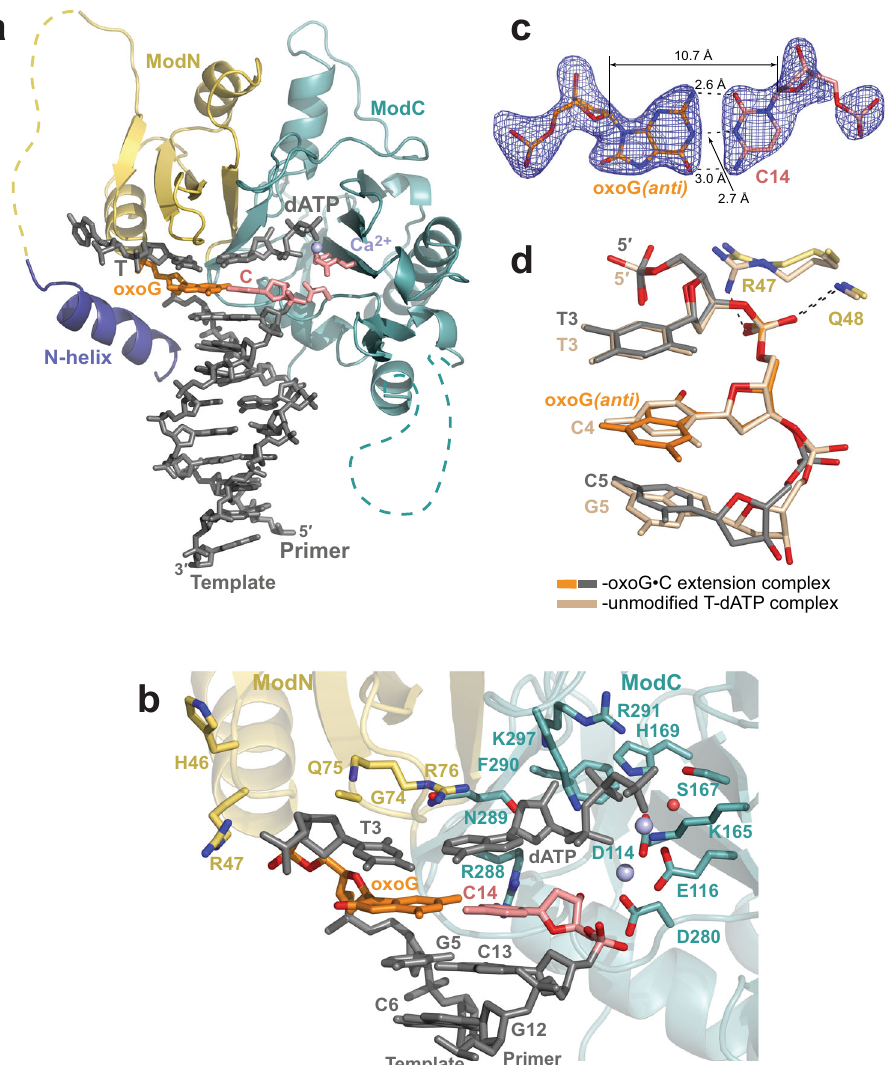
Fig. 3 Structure of human PrimPol extending from a correct primer C base opposite the oxoG template base. a The overall structure of the ternary PrimPol oxoG • C extension complex (molecule A of the asymmetric unit, AU). The N-helix and modules ModN and ModC are shown in cartoon representation in dark blue, yellow, and cyan, respectively. The DNA is shown as gray sticks, the Ca 2 + ion ( ‘ metal B ’ ) is shown as a light blue sphere. The oxoG residue (orange) is forming a base pair with the primer terminal C base (red). The incoming dATP forms a nascent base pair with a template T base, which is 5 ′ -adjacent to the oxoG residue. The unstructured regions in the ModN and ModC modules are shown as dashed yellow and cyan lines, respectively. The side chains of key catalytic active-site residues Asp114, Glu116, and Asp280 are shown as red sticks. b A close-up view of the oxoG template base and the 3 ′ -deoxy primer C14 base in the PrimPol active site (molecule B in the AU). There are two Ca 2 + ions (metal ‘ A ’ and ‘ B ’ ) in this complex shown as light blue spheres, and the water molecule coordinated by the Ca 2 + ion is shown as a small red sphere. The key catalytic residues (Asp114, Glu116, and Asp280), the residues contacting the incoming dATP (Lys165, Ser167, His169, Arg288, Asn289, Phe290, Arg291, and Lys297), the templating base (Gly74, Gln75, and Arg76), and the rest of the template strand (Lys10, His46, and Arg47) are shown in sticks and with oxygen atoms in bright red and nitrogen atoms in blue. c A simulated annealing Fo − Fc omit map (contoured at 2.5 σ -level at 2.10 Å resolution and colored in blue) showing the clear electron density for the entire oxoG residue in the anti conformation and its partner C14 residue. Hydrogen bonds are indicated by black dashes. d Similar phosphate backbone conformations of T3-oxoG4 (anti) -C5 (gray and orange) and unmodi fi ed T3-C4-G5 (beige) template strand segments within the PrimPol active site of their respective ternary complexes. The complexes are superimposed by ModN and ModC of PrimPol protein. The main-chain nitrogen atom of Gln48 contacts the oxygen atom of the phosphate group of the oxoG (anti), similarly to its contact with the phosphate group of the C4 in the unmodi fi ed complex. The guanidinium group of Arg47 of ModN, however, repositions to contact a neighboring protein chain in the crystal (main-chain oxygen atom of Gly124 of a symmetry-related molecule, not